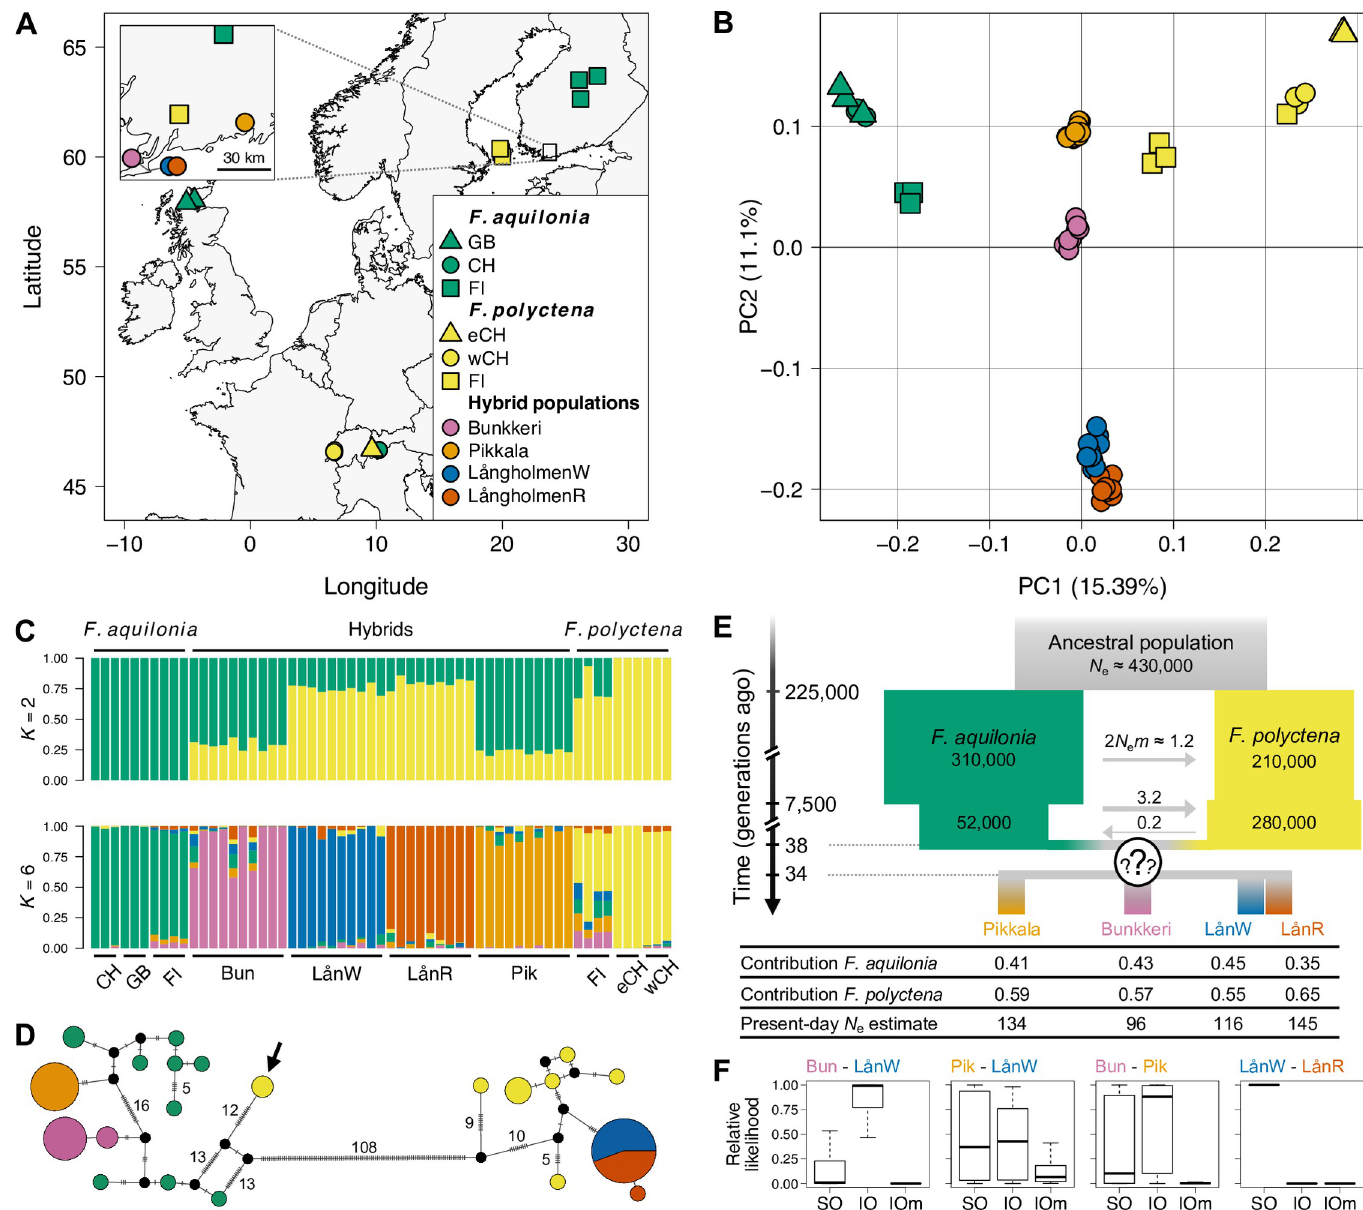
Fig 1. Young AU : AbbreviationlistshavebeencompiledforthoseusedinFigs 1 to 3 : Pleaseverifythatallentriesarecorrect : , independently evolving hybrid wood ant populations between F . aquilonia and F . polyctena in Southern Finland. (A) Sampling sites across Europe (eCH: East Switzerland, wCH: West Switzerland, map base layer from Natural Earth: https://www.naturalearthdata.com/downloads/110m-physical-vectors). (B) Principal